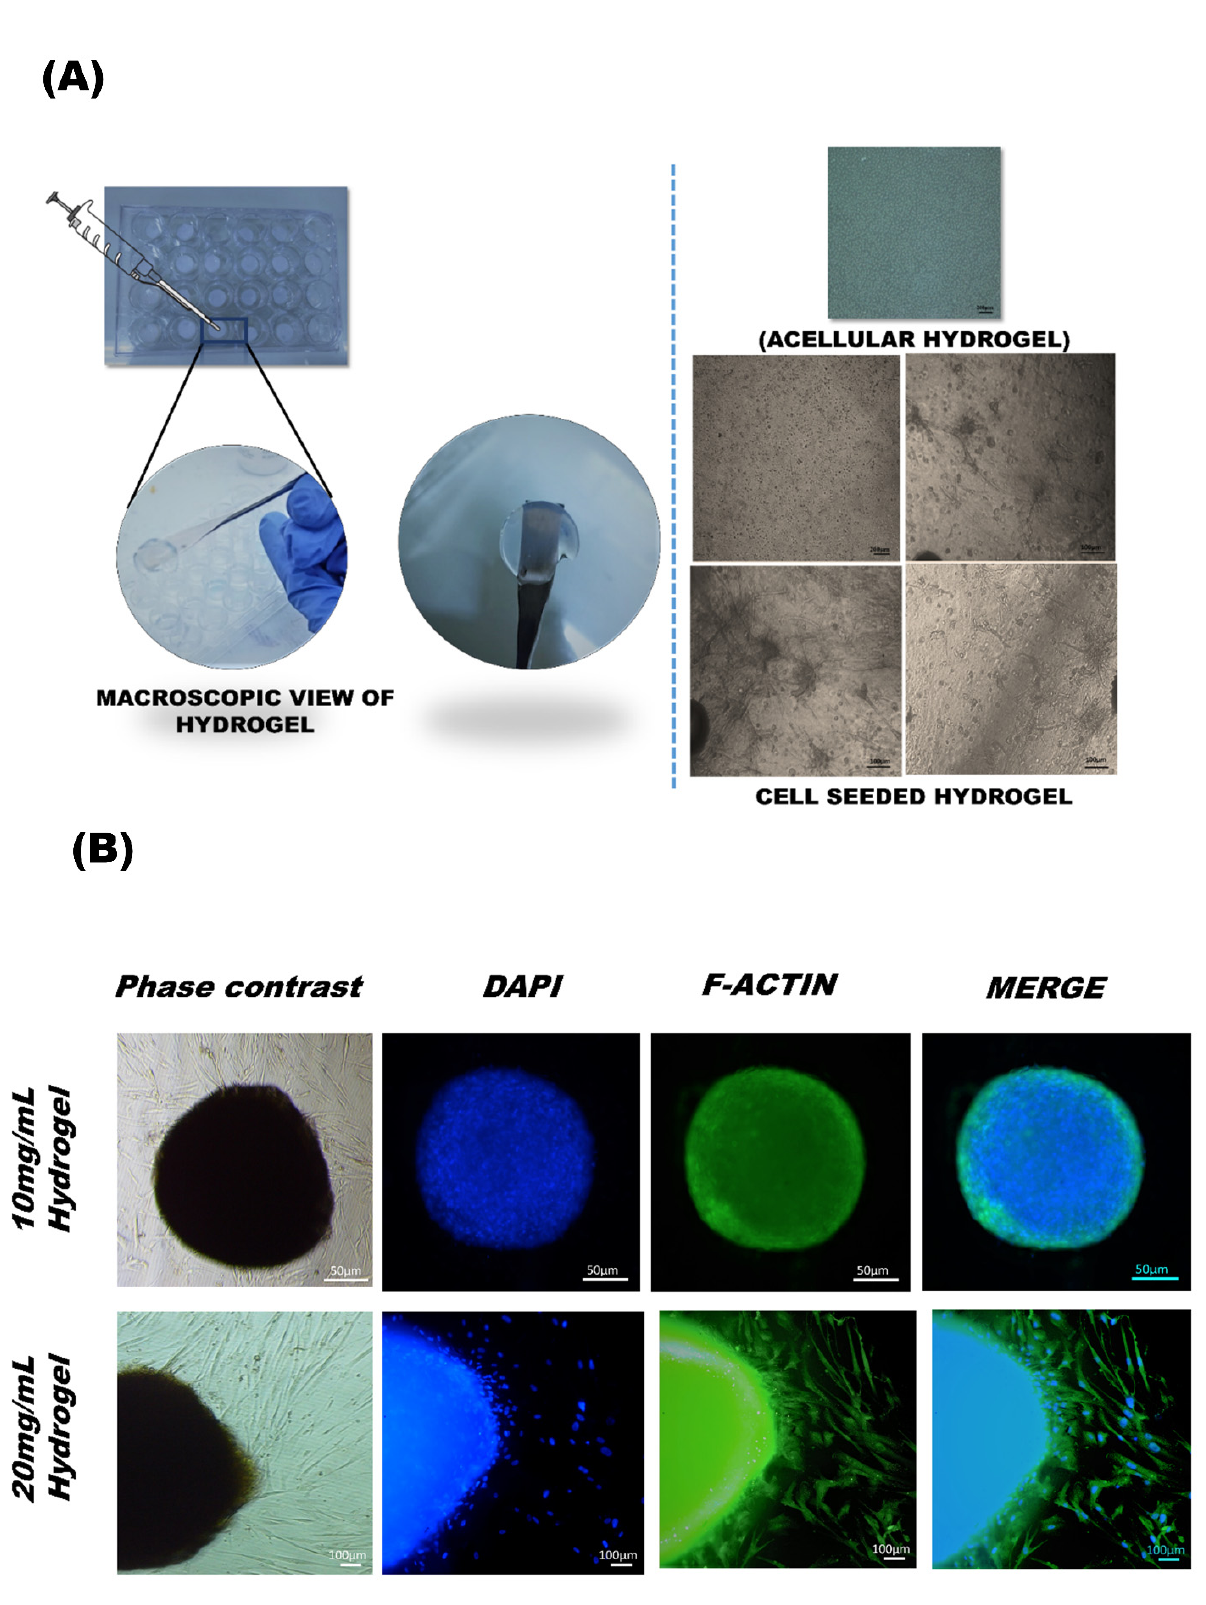
Figure 5. ( A ) Phase contrast images of hydrogel without and with cells show morphology of 3D encapsulated MSCs with a density of 0.2 million cells/mL. The cells in the decellularized hydrogel attached and maintained their 3D shape spindle shape after 24 h. ( B ) Immunofluorescence showing phase contrast, DAPI, and F-actin stained images of cell-seeded hydrogel.